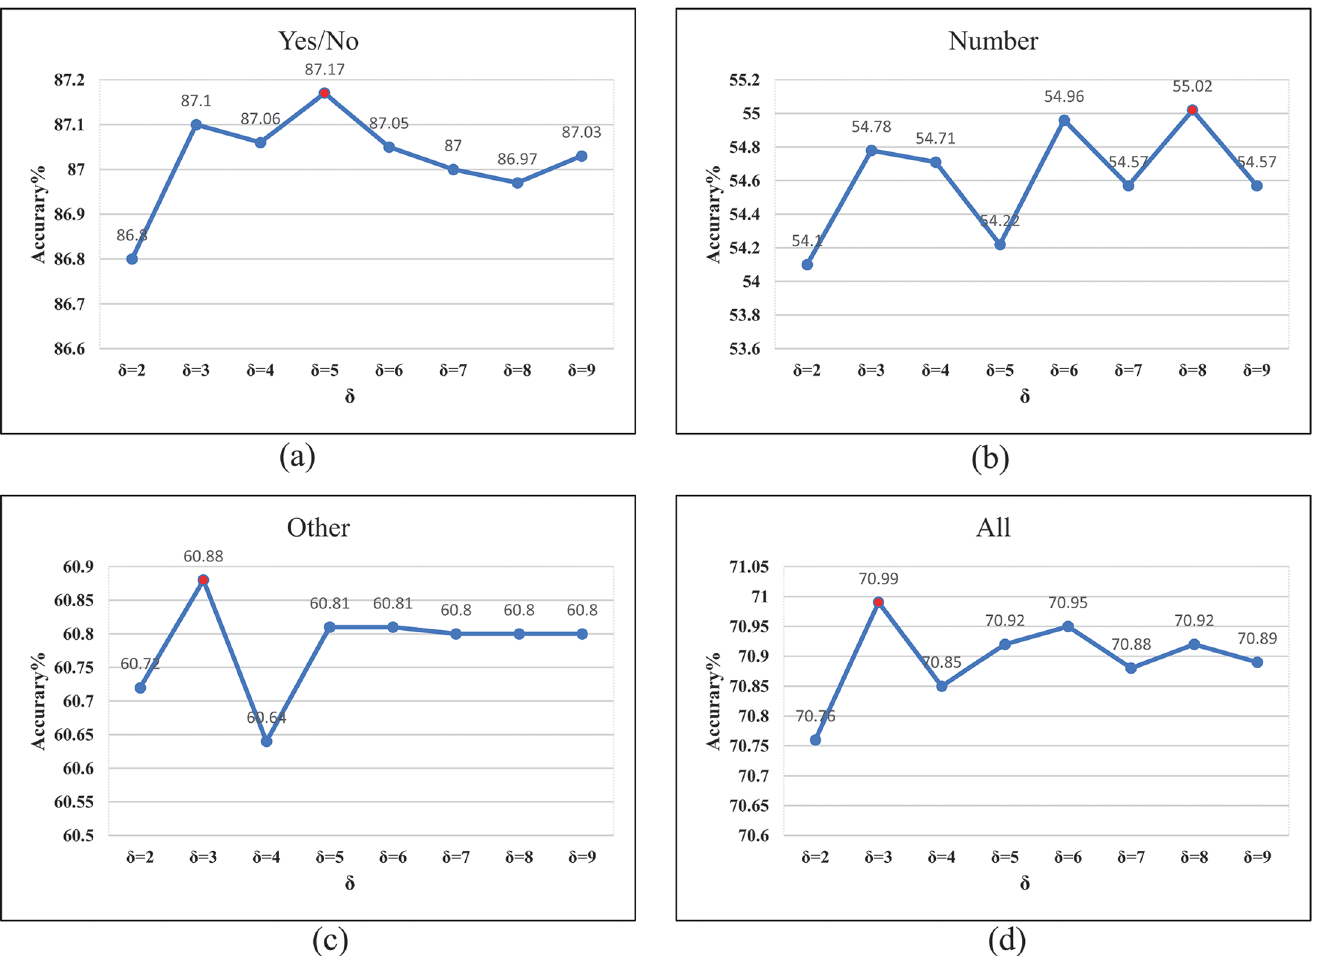
Fig 7. (a) The accuracy of “Yes/No” based on different parameters. (b) Accuracy of “Number” based on different parameter. (c) Accuracy of “Other” based on different parameters. (d) Accuracy of “All” based on different parameters.